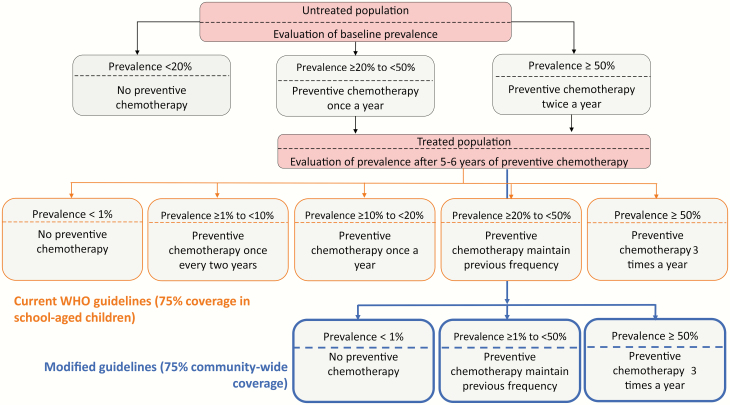
World Health Organization (WHO) decision tree showing the current WHO guidelines to achieve morbidity control in school-aged children (SAC) using 75% coverage in SAC (black and orange boxes). The blue boxes represent the modified guidelines assuming 75% community-wide coverage (pre-SAC, SAC, and adults) to replace the orange boxes (adapted from [1]).